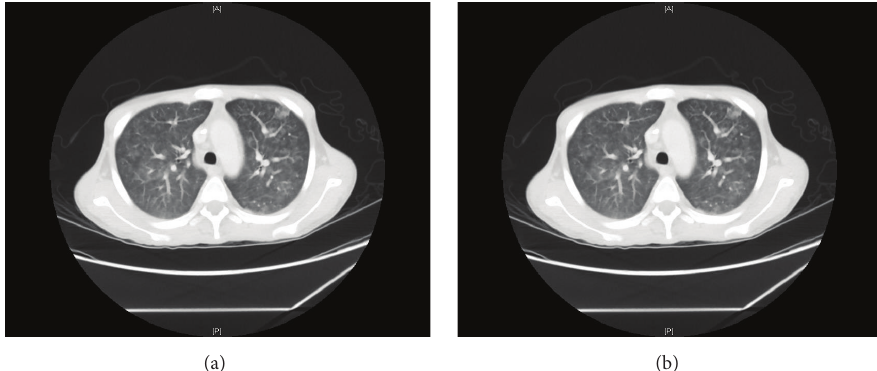
Figure 3: (a) CT scan showing ill-defined centrilobular nodules. (b) CT scans showing ill-defined ground glass density mainly in the upper lobes.